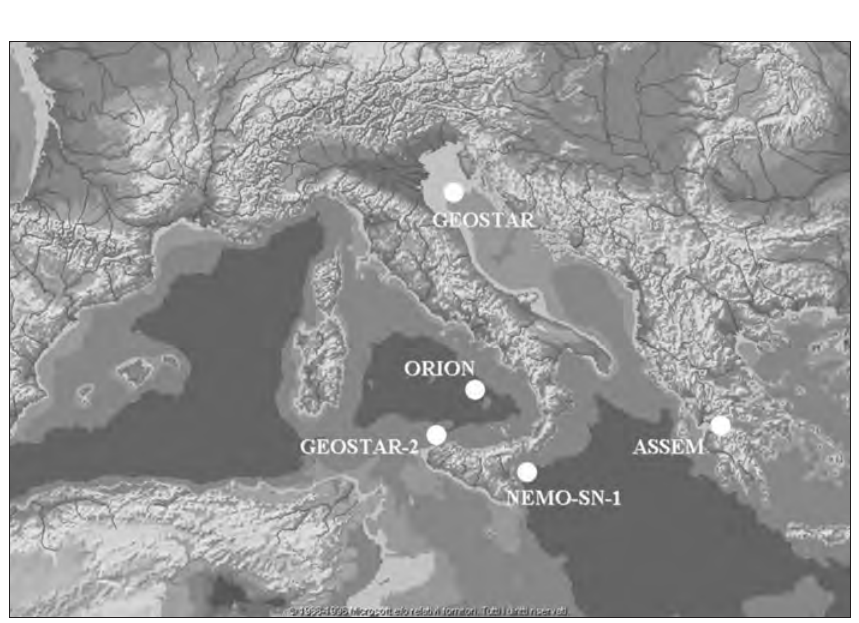
table VI), SN-1 acquired in autonomous mode,